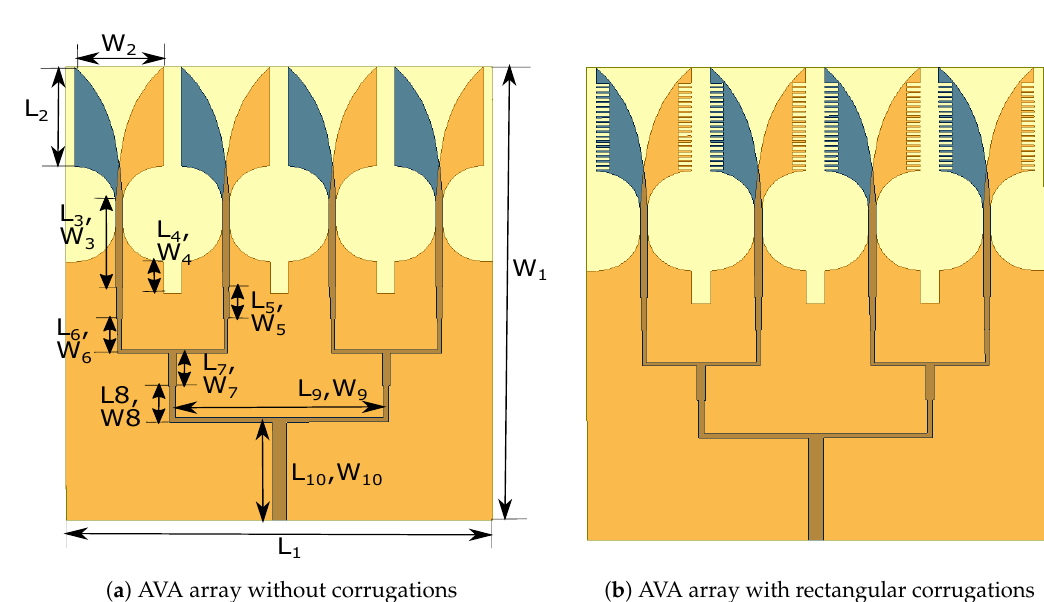
Figure 6. Design of proposed antenna.